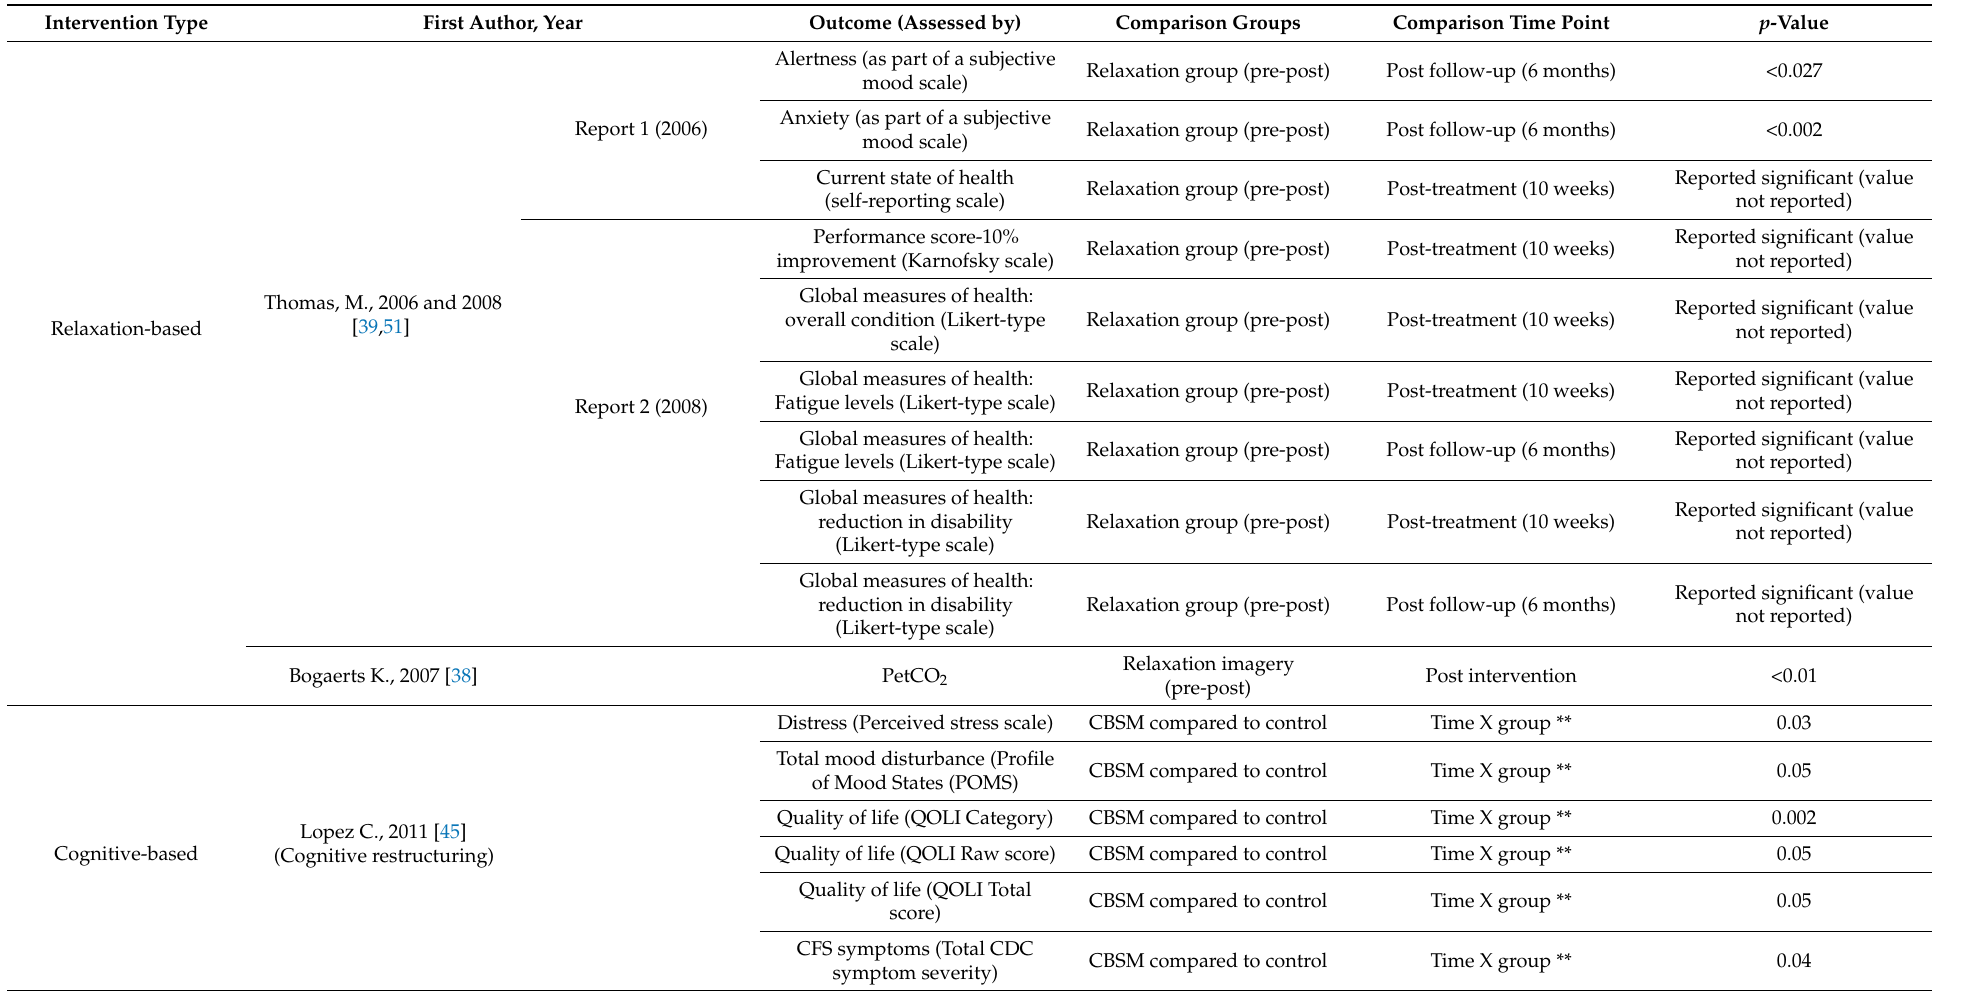
Table 3. Significant outcomes in the included studies using CDC, Canadian and international consensus criteria for diagnosing